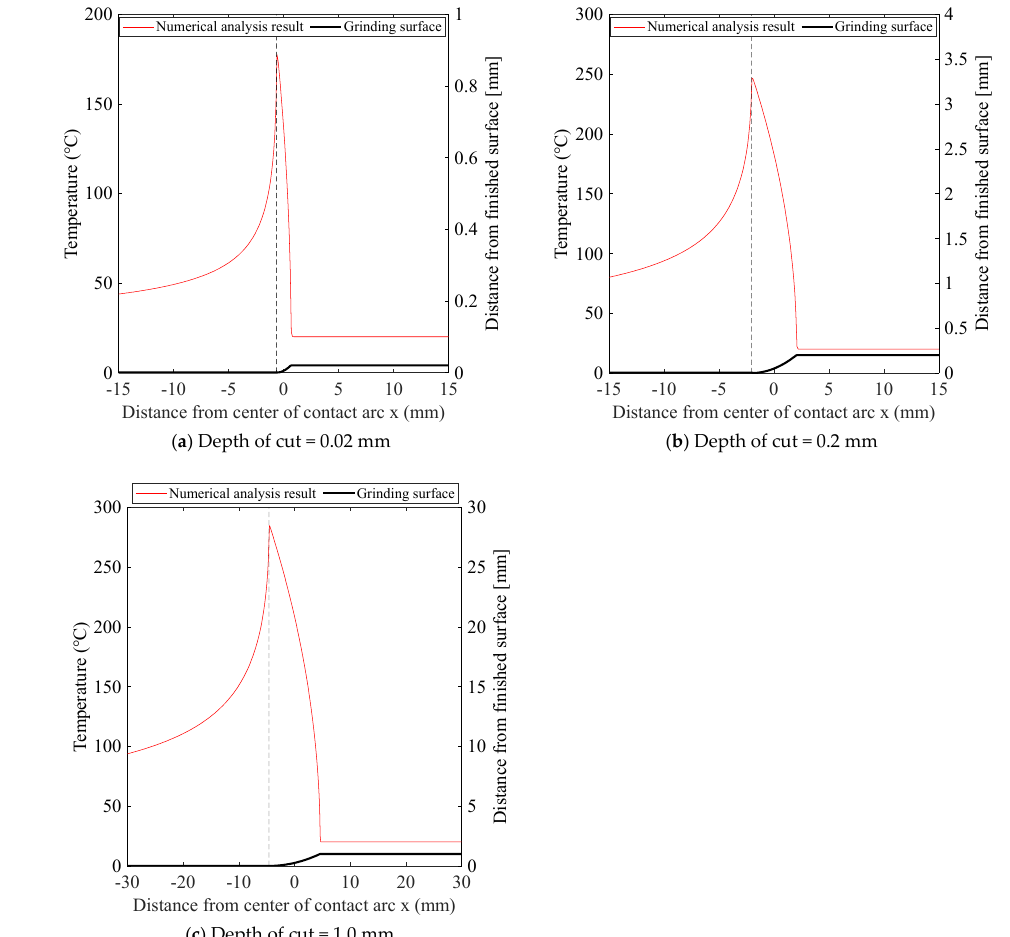
Figure 14. Temperature distribution in the feed direction.